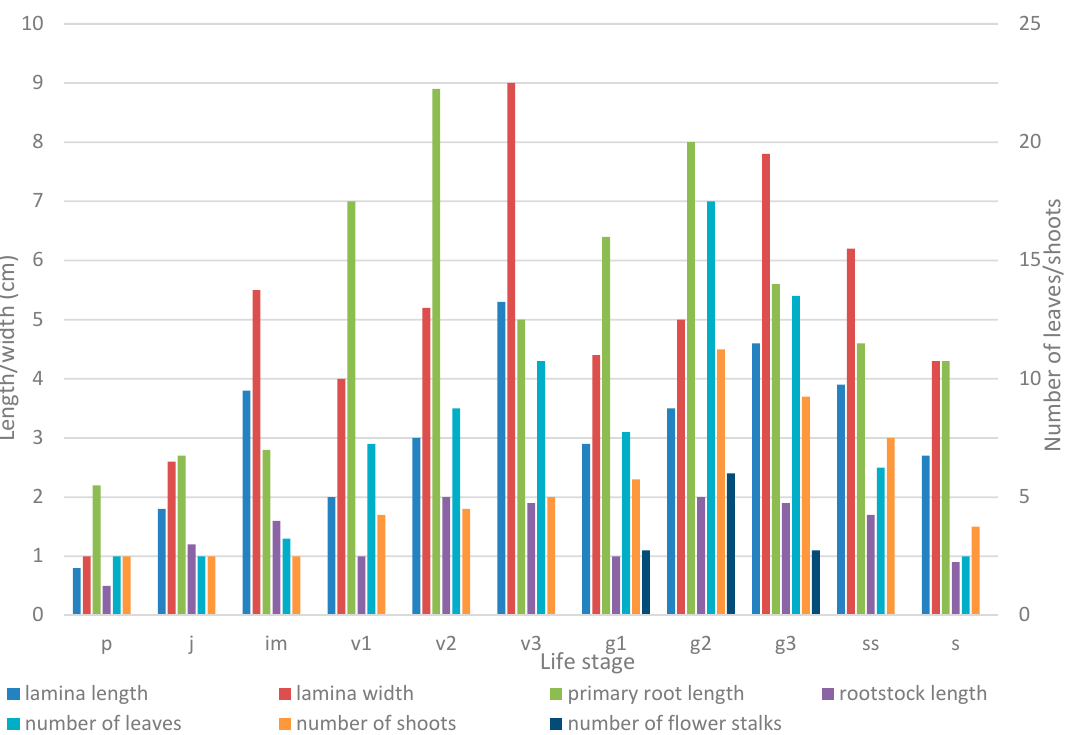
Figure 3. The change of some morphological characteristics during the ontogeny of Anemone patens. Chart represents means ( X ̅ ) of the study structures for each life stage: p—seedling, j—juvenile, im—immature, v 3 —old virginile, g 3 —old generative, ss—subsenile, and s—senile. Flower stalk length (g 3 ) is not shown on the figure because data are too large.